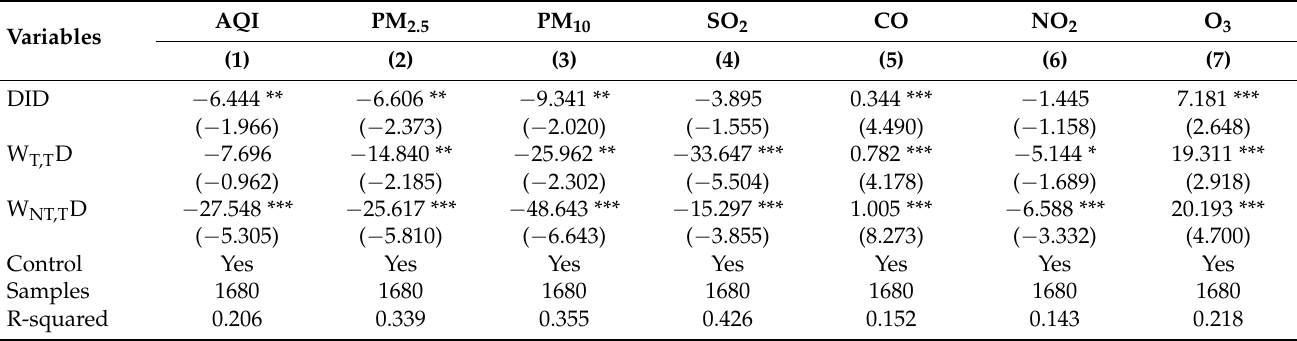
Table 3. The spatial results based on the SDID